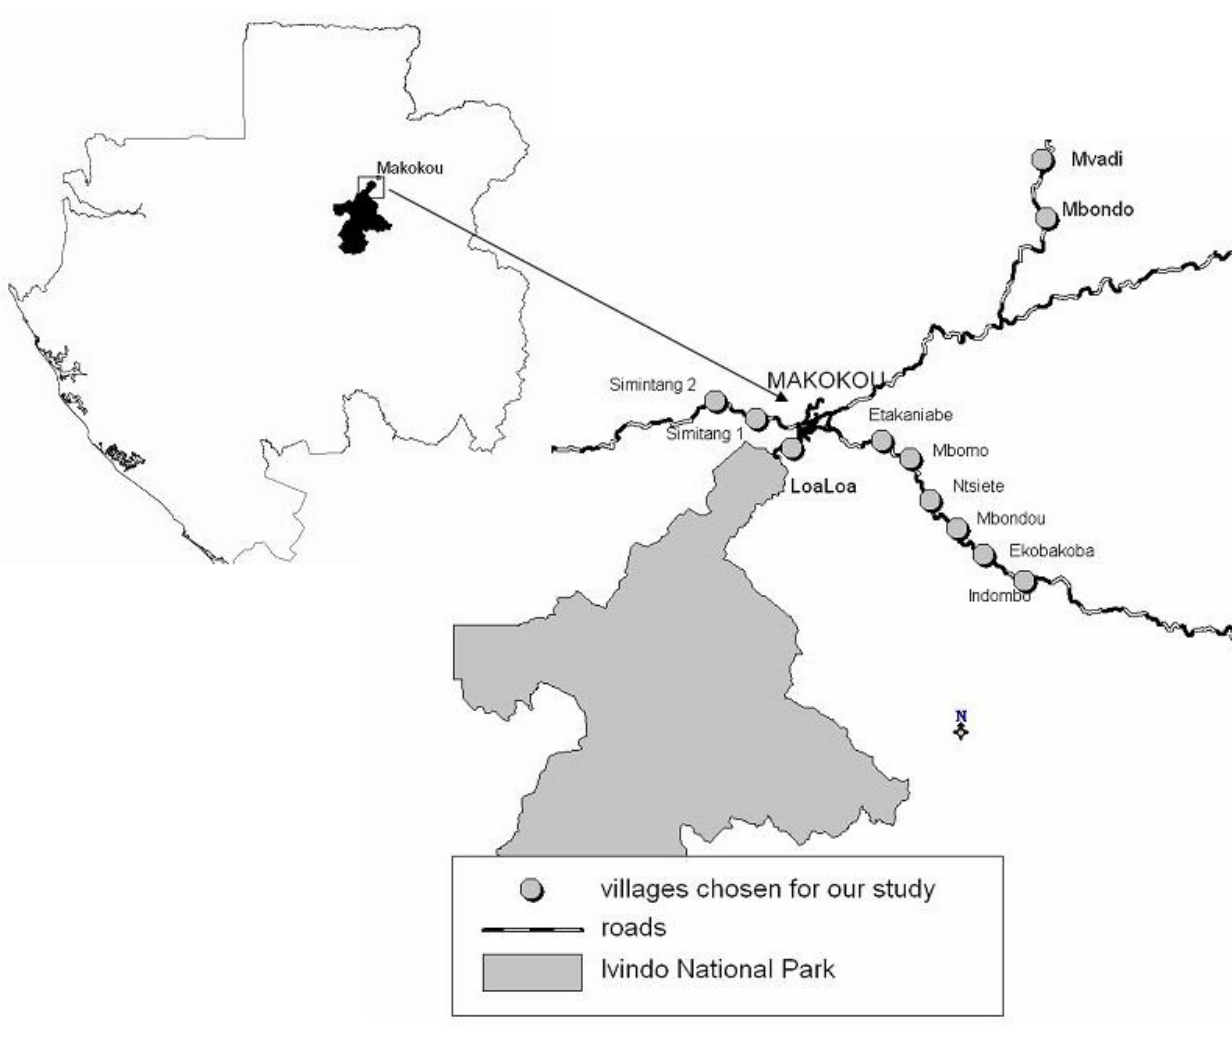
Fig. 1. Eleven villages near the town of Makokou in which we interviewed hunters about their hunting